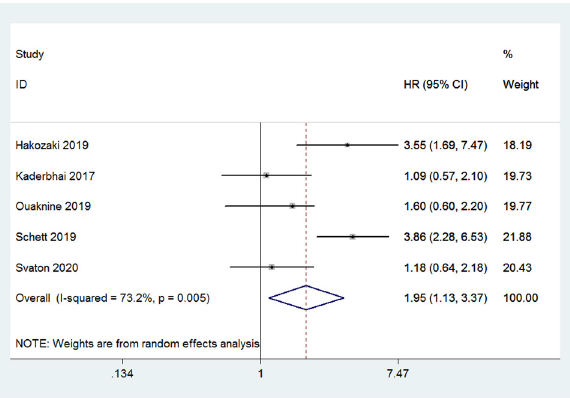
Figure 2: Forest plot of the pooled PFS based on exposure to antibiotics.